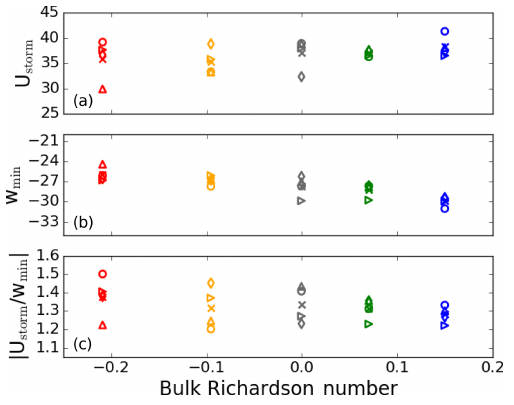
Figure 9. Variations of U storm (a) , w min (b) , and the ratio between the two (c) for each case – C1 (red), C2 (yellow), N (gray), S1 (green), and S2 (blue) – with the average bulk Richardson num- ber at the first model level over the first 3min of simulation. Cir- cles represent the 0x_0y cases, the right-pointing triangles represent the 5x_0y cases, the upward-pointing triangles represent the 0x_5y cases, and the diamonds represent the 5x_5y cases. The ensemble mean is denoted by an ”x” for each case.